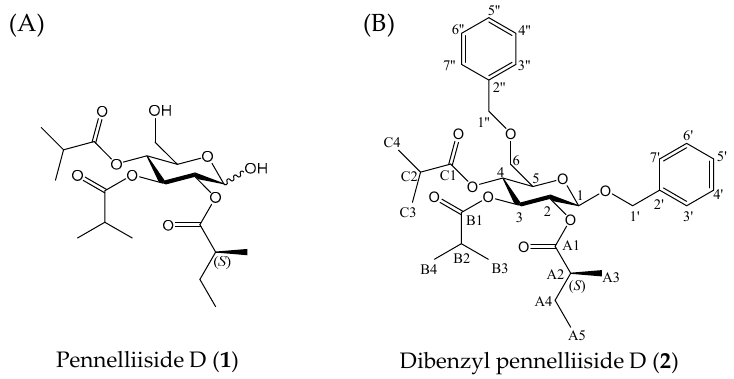
Figure 1. Structure of pennelliisides D and its benzylated derivative.